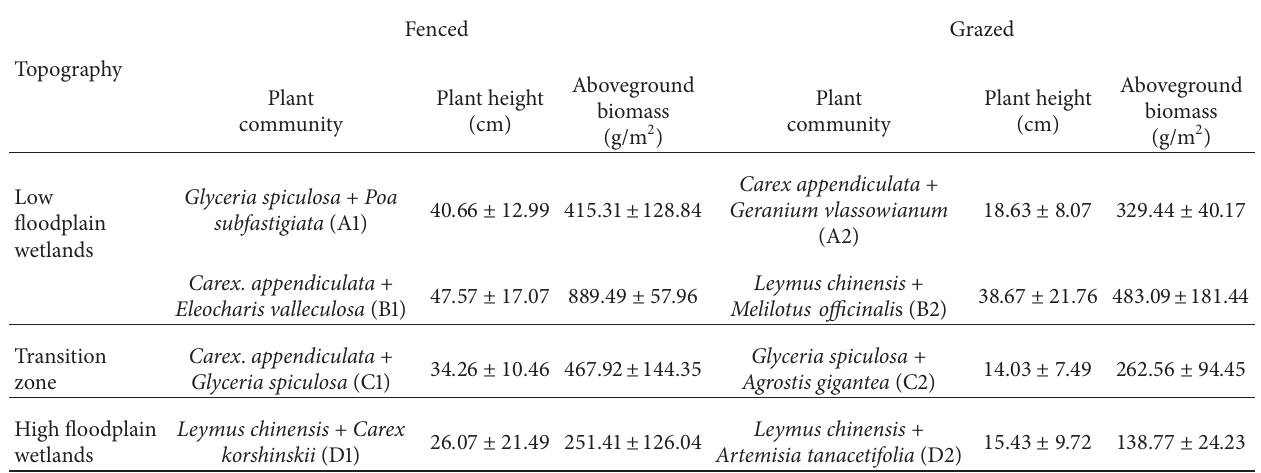
Table 1: The composition of plant community in the study sites.